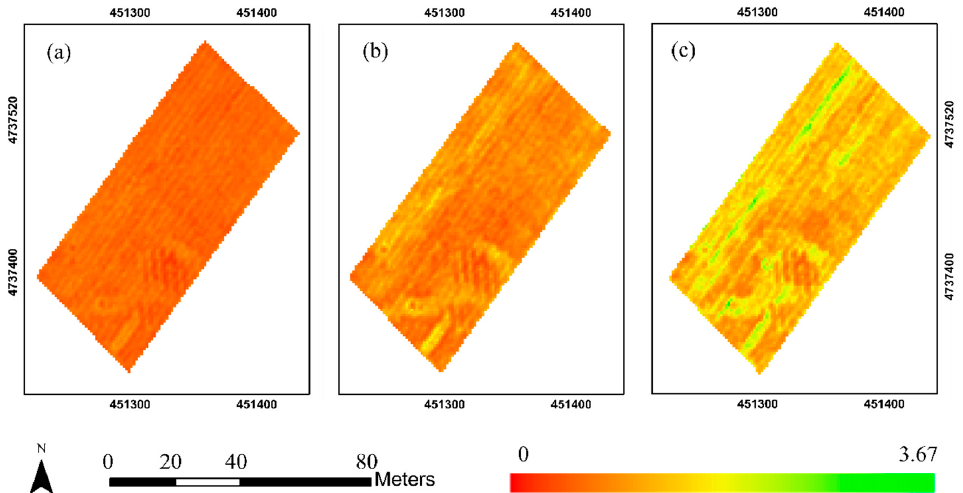
Figure 4. The SOPC derived UAV-based point cloud e ff ective leaf area index (LAIe) maps for S2. ( a ) LAIe map on 11 May 2019; ( b ) LAIe map on 21 May 2019; ( c ) LAIe map on 27 May 2019.